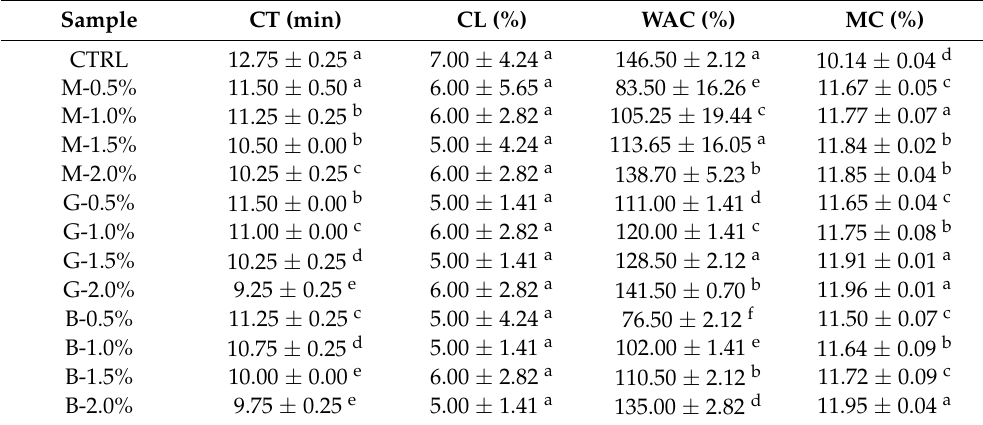
Table 4. Cooking properties of